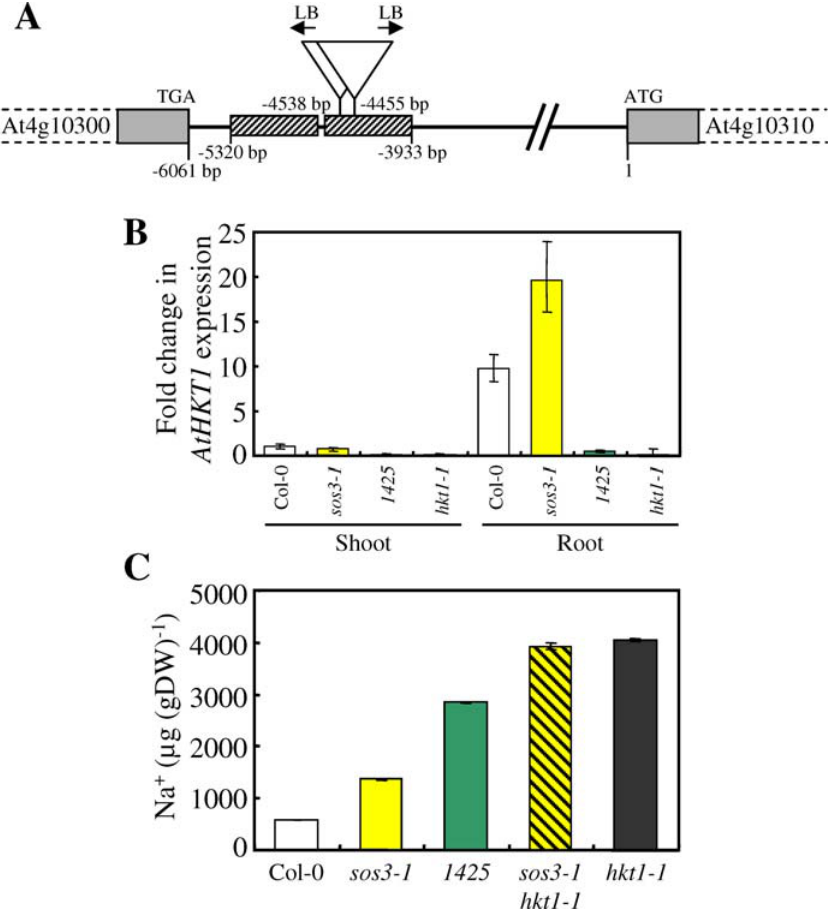
Figure 5. The Tandem Repeat Upstream of At HKT1 Is Determinant for At HKT1 Expression and Maintenance of Shoot Na þ Accumulation (A) Diagram of the T-DNA insertions in Line 1425. Represented are the two tandem repeats (hatched boxes), positions of the two T-DNA insertions (inverted triangles), and the arrows indicating the orientation of the left border (LB) for each T-DNA insertion. Numbering is based on the A of the At4g10310 start codon ATG as þ 1. The diagram is not drawn to scale. (B) At HKT1 expression using quantitative real-time PCR in Col-0, sos3–1 (Col-0 gl1 ), Line 1425, and hkt1–1 . RNA was isolated from shoot and root of 6-wk- old plants grown in soil under short-day conditions. For normalization across samples, the expression of the Actin 1 gene was used, and relative fold induction was calculated in comparison to At HKT1 expression in Col-0 shoot using the DD C t method. Presented data are the mean of at least three biological replicates, and the error bars represent 6 SD. (C) Na þ accumulation in shoot tissue of Col-0, sos3–1 (Col-0 gl1 ), Line 1425, sos3–1 hkt1–1, and hkt1–1 grown for 6 wk in soil under short-day conditions (same plants used for quantitative real-time PCR above). Presented data are the mean 6 SE ( n ¼ 12).